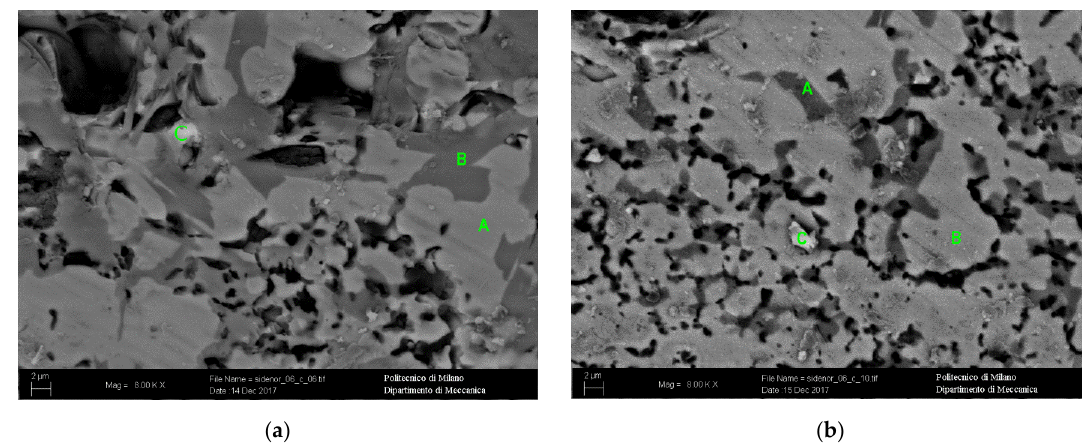
Figure 11. SEM micrographs ( a , b ) of as-received coarse combustion chamber residues.